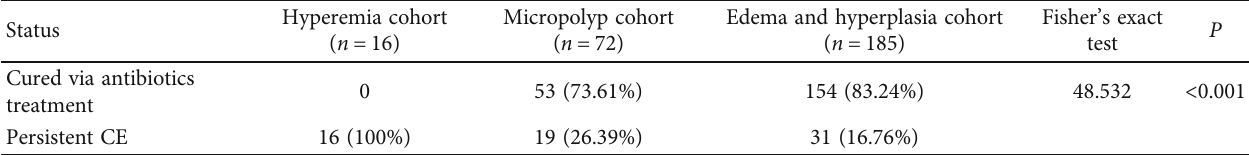
Table 2: The e ff ect of antibiotics treatment examined by